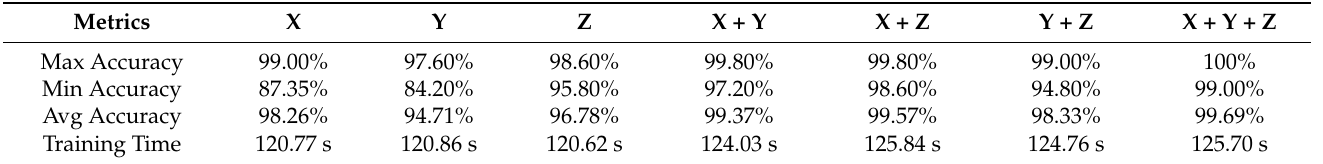
Table 4. Performance of the proposed model tested by the data sets formed using different combina- tion of vibration signals from data set